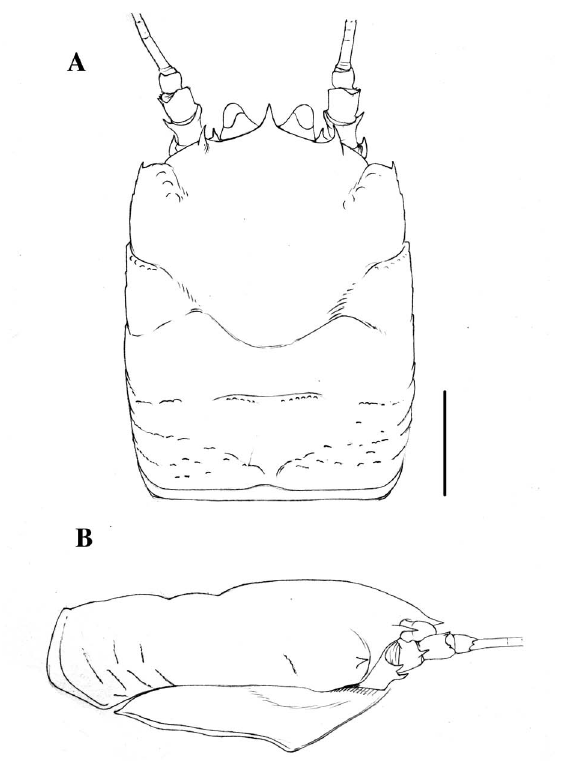
Fig . 2. – Munidopsis polymorpha Koelbel, 1892, male 7.2 mm (MNHN-Ga185), carapace. A, dorsal view. B, lateral view. Scale: 3.5